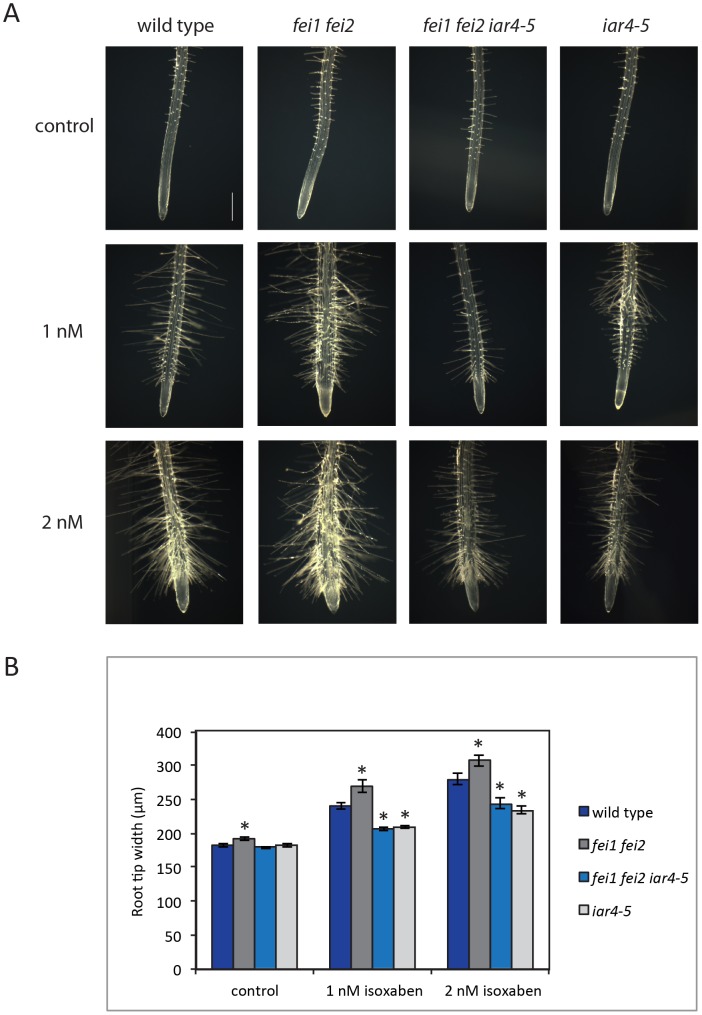
Mutations in IAR4 confer resistance to isoxaben.(A) Root phenotypes of indicated seedlings germinated and grown for five days on MS medium with 0% sucrose and then transferred for 48 hours to MS medium with 0% sucrose containing either 0 nM (DMSO), 1 nM or 2 nM isoxaben. Representative root tips were imaged using dark field microscopy. Scale bar = 0.5 mm. (B) Quantification of the root tip swelling from (A). The width of the roots was measured at the level of the youngest root hair using ImageJ software [48]. Values are the means (n>8) ± SE. Data were analyzed by unpaired Student's t-test. Asterisks indicate significant differences relative to the wild type; P<0.05.